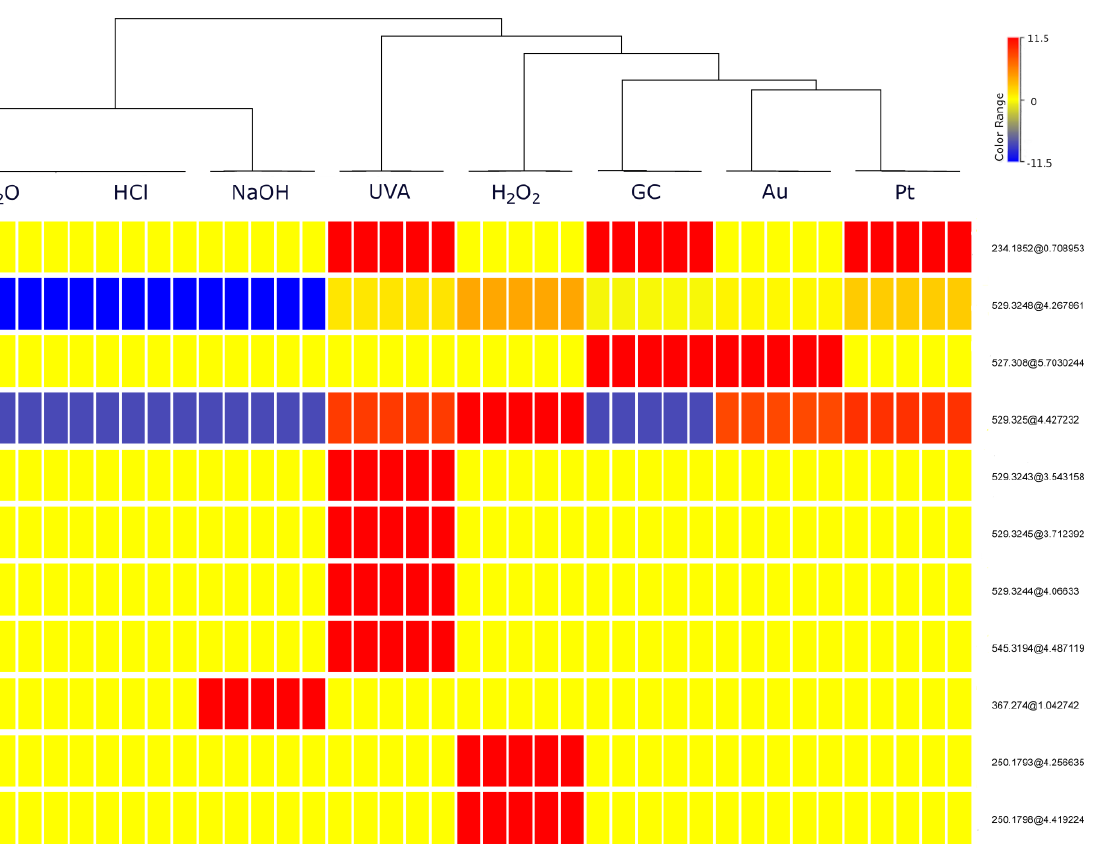
Figure 2. Hierarchical cluster analysis (HCA), (entities abbr.—mass@retention times). Each rectangle represents one entity (i.e., a transformation product or its fragment), and a color of bar—normalized concentration, ranging from very low to moderate and very high, which are shown in blue, yellow and red, respectively.